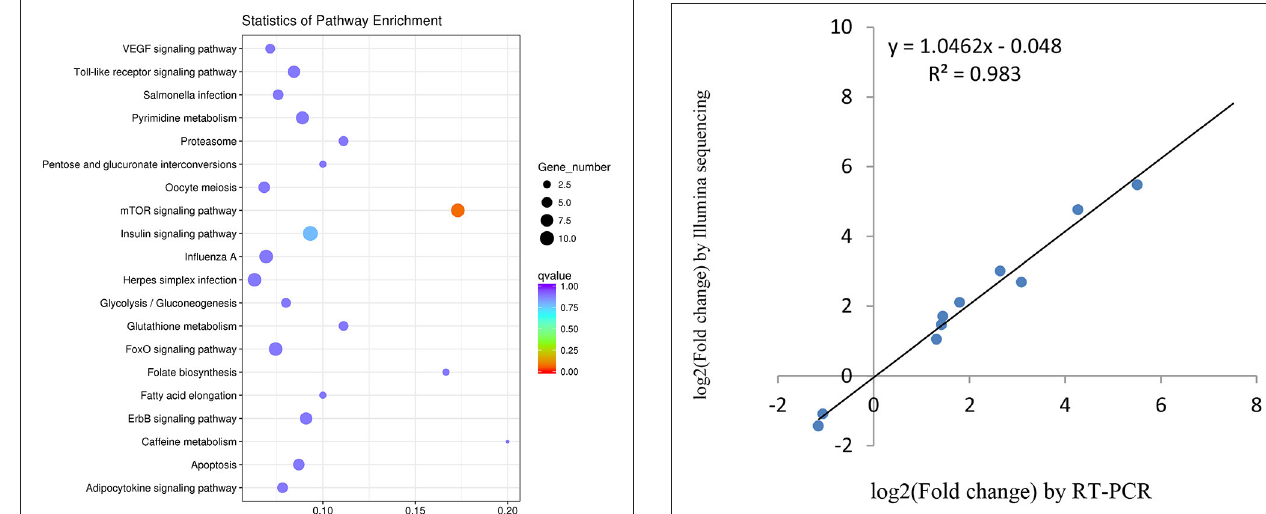
FIGURE 18 | qRT-PCR validation of differentially expressed